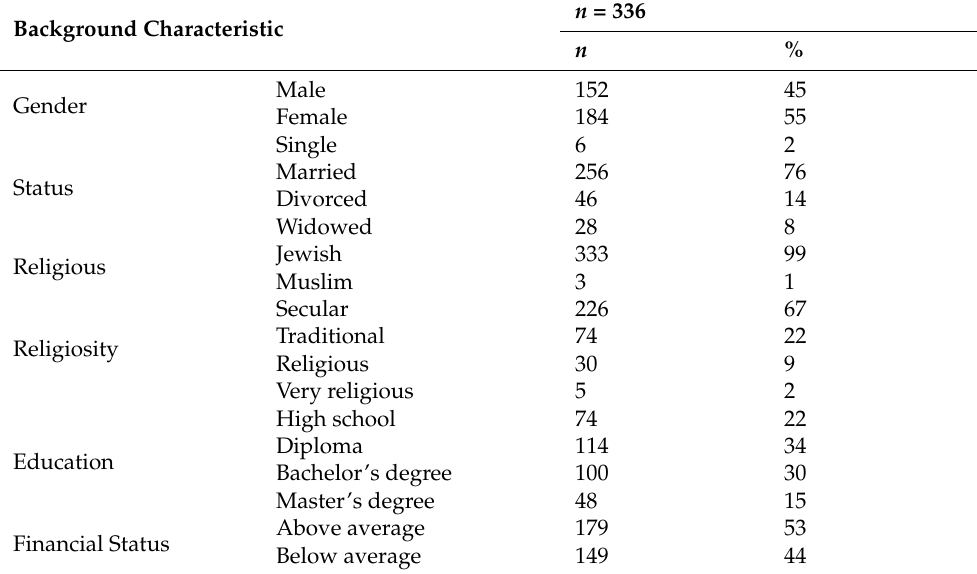
Table 1. Background characteristics of the study